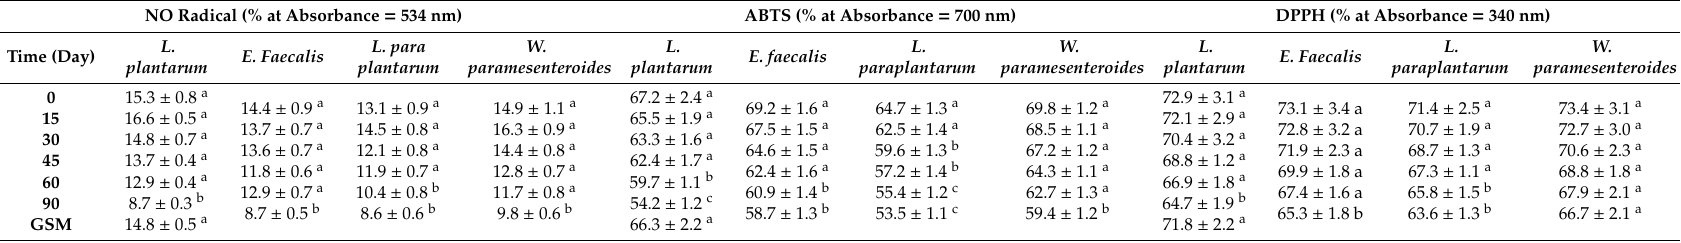
Table 6. Antioxidative properties of the grape marmalade (percentage inhibition). NO—nitric oxide; ABTS—2,2’-azino-bis(3-ethylbenzothiazoline-6-sulfonic acid);